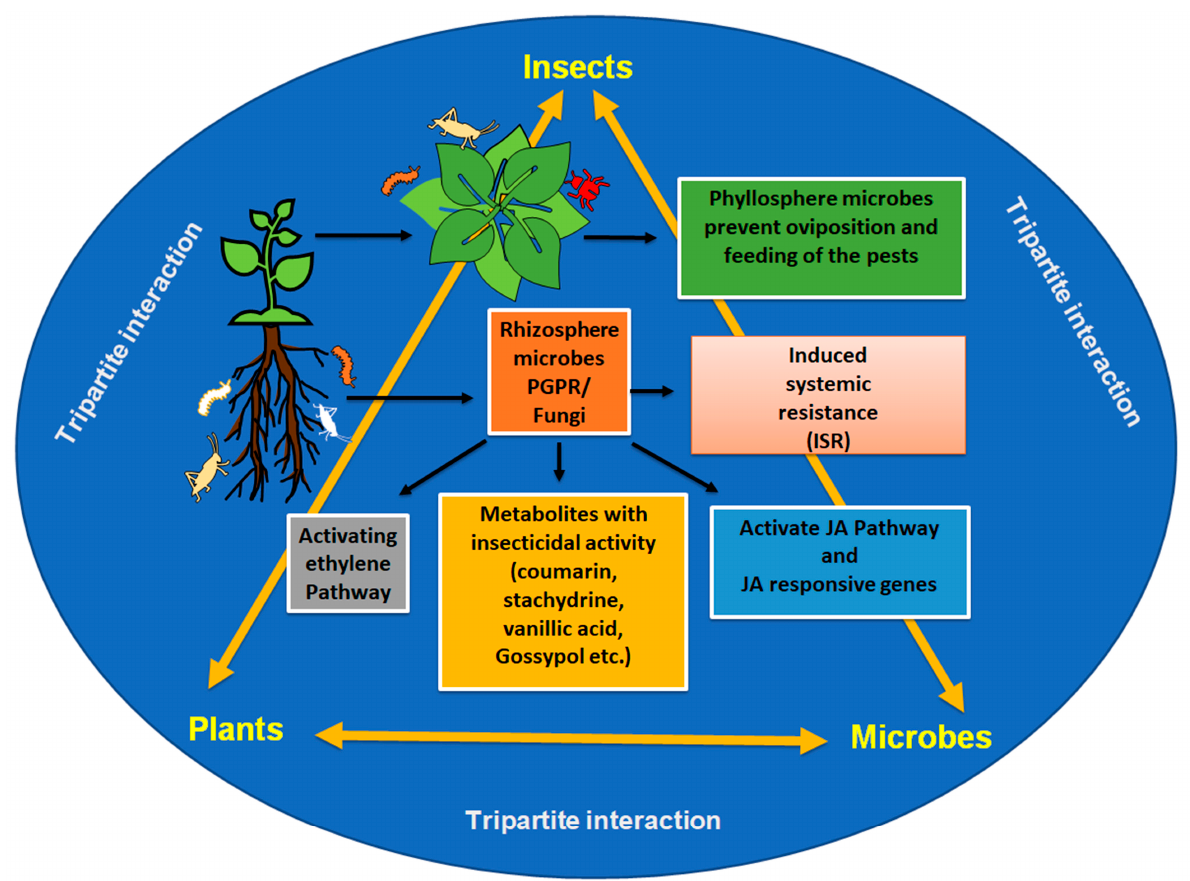
Figure 2. The influence of phyllosphere and rhizosphere microbiome on plant–insect interplay.